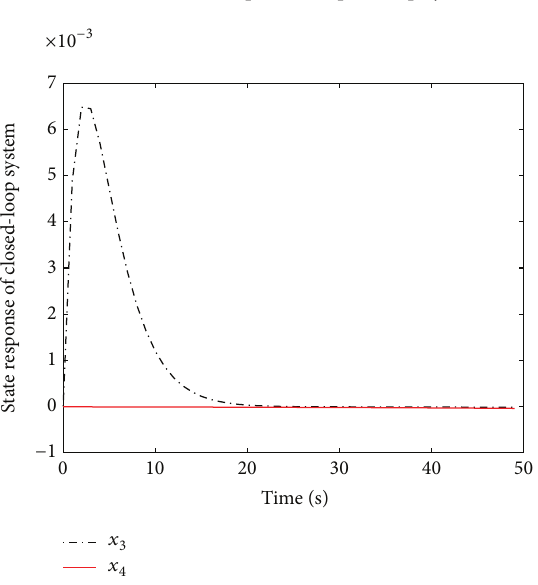
Figure 7: The state response of closed-loop